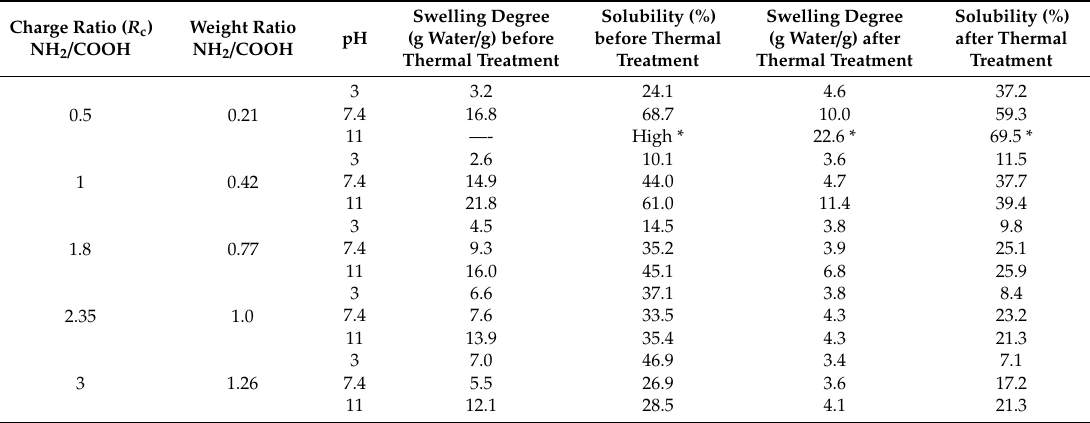
Figure 3. Influence of the thermal treatment (4 h at 120 °C) on PEC films solubility and degree of swelling as a function of charge ratio at pH = 7.4. Average values shown after repeating the experiment 4 times. Table 1. Influence of Charge Ratio R c and pH on Swelling Degree and Solubility (%) before and after Thermal Treatment for Solubilization in W / FA 50 /